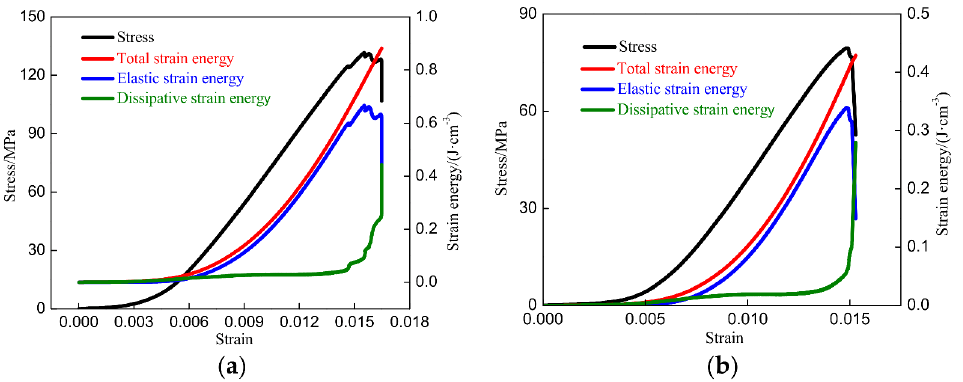
Figure 10. The curve of strain energy with maximum stress. ( a ) Dry rock samples. ( b ) Saturated rock